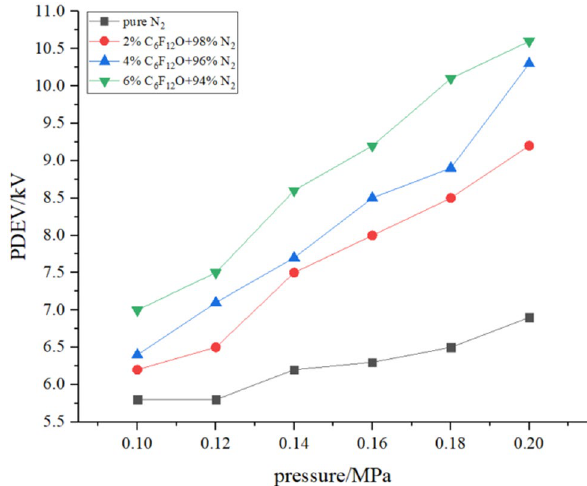
Figure 7. PDEV with the pressure.